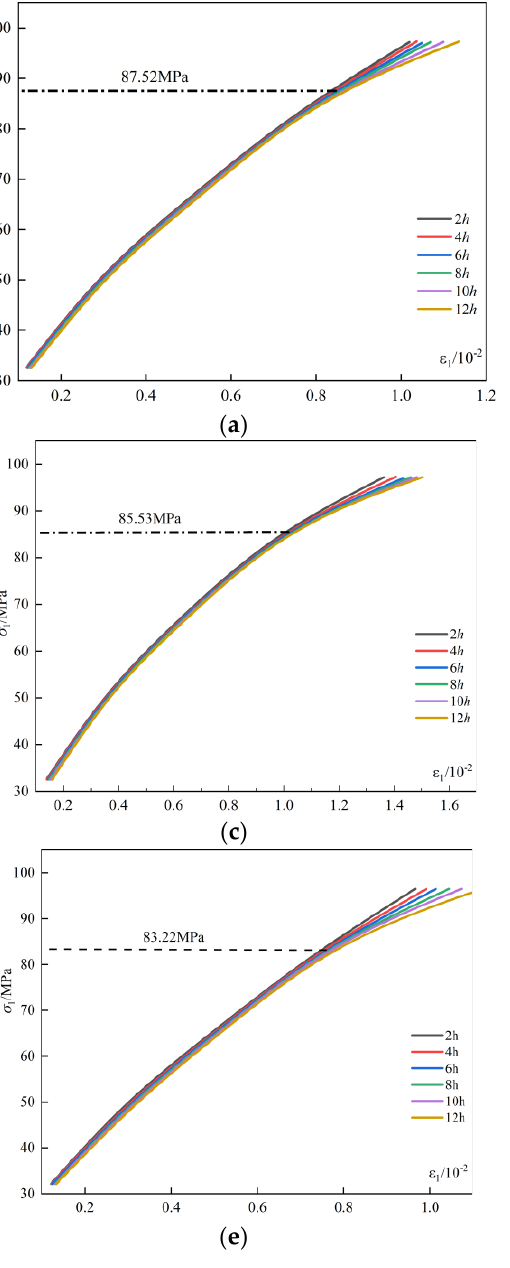
Figure 7. Isochronous curve cluster of the unloaded sample (where ( a , c , e ) and ( b , d , f ) are initial confining pressures of 15 MPa and 21 MPa, respectively). ( a ) R15-0. ( b ) R21-0. ( c ) R15-7. ( d ) R21-7. ( e ) R15-14. ( f ) R21-14.